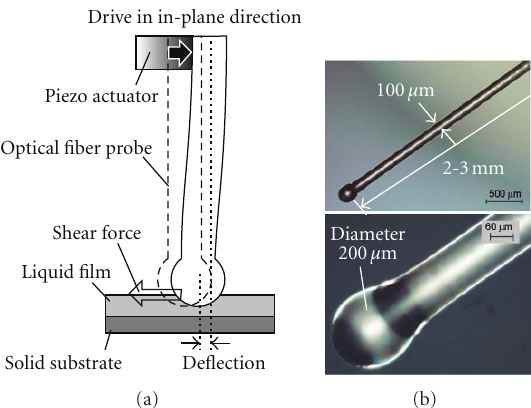
Figure 1: (a) Concept of shear force detection in the fiber wobbling method and (b) micrographs of the optical fiber probe.